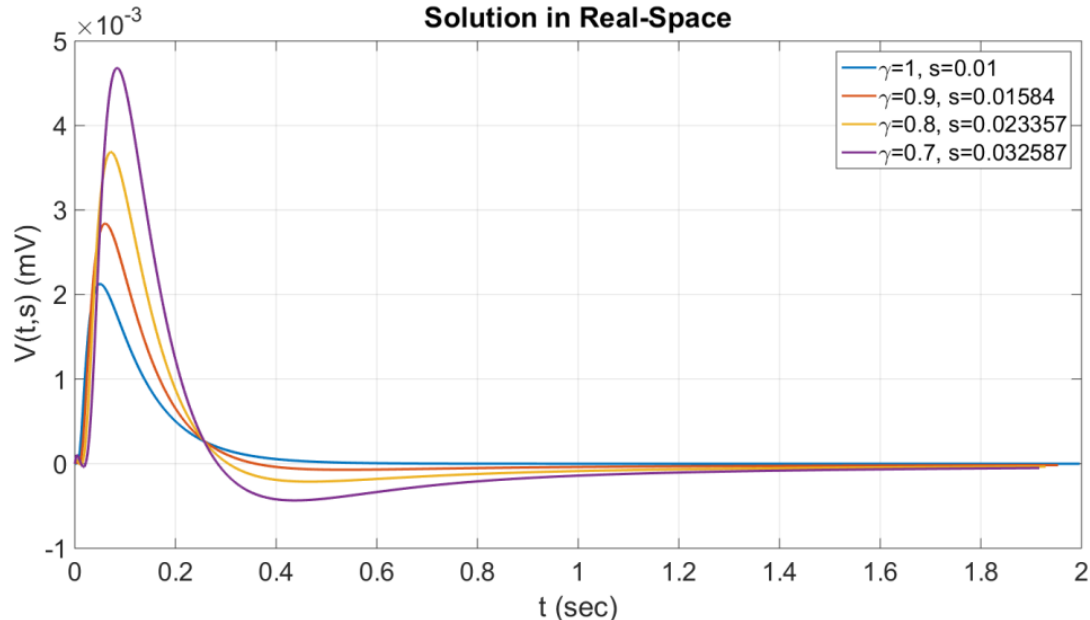
Figure 1. The voltage V(t,s) for various values of fractional order γ and corresponding values of s in real space (S = 0.01).